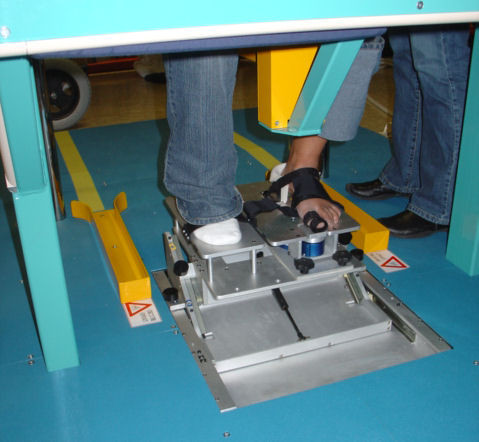
The Foot Device.